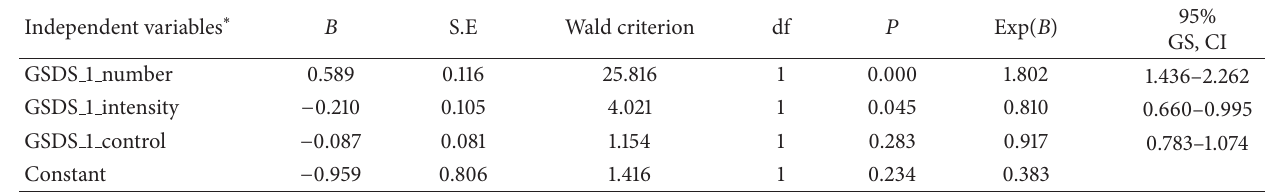
Table 6: Risk of general health condition affected by distress in seafarers before the